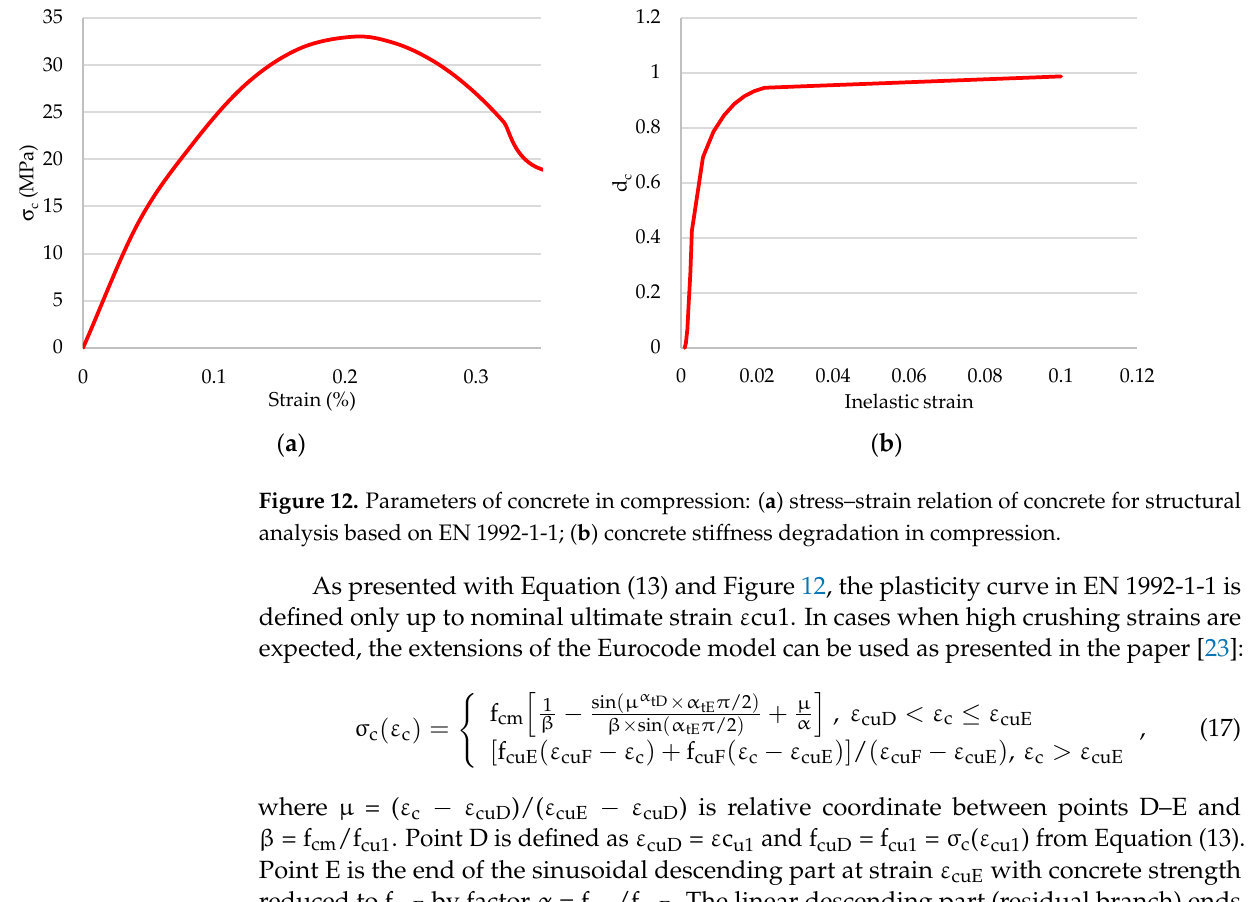
Figure 13. Parameters of concrete in compression, an extension of EN 1992-1-1 model. The extension of the EN 1992-1-1 model does not change the presented models’ results, which means that the compression strains are below strain ε cu1 .